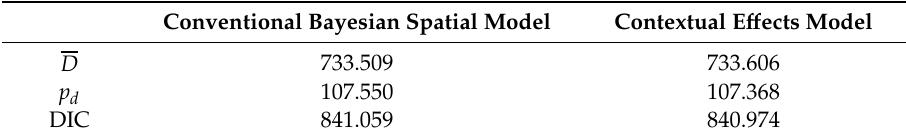
Table 2. Deviance summaries of the conventional and the contextual e ff ects